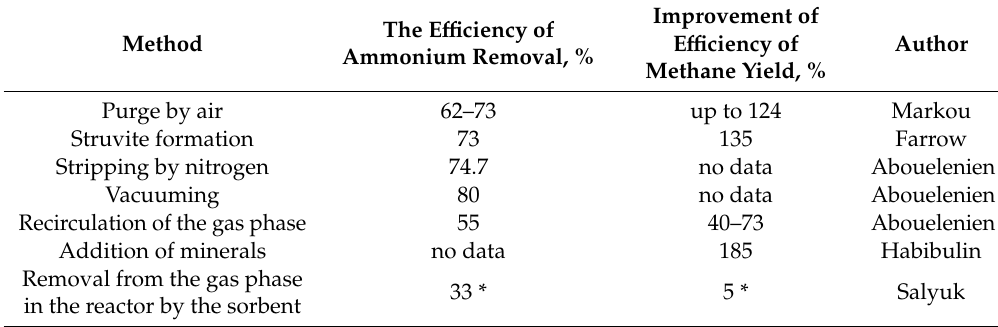
Table 5. The e ffi ciency of ammonia removal under dry